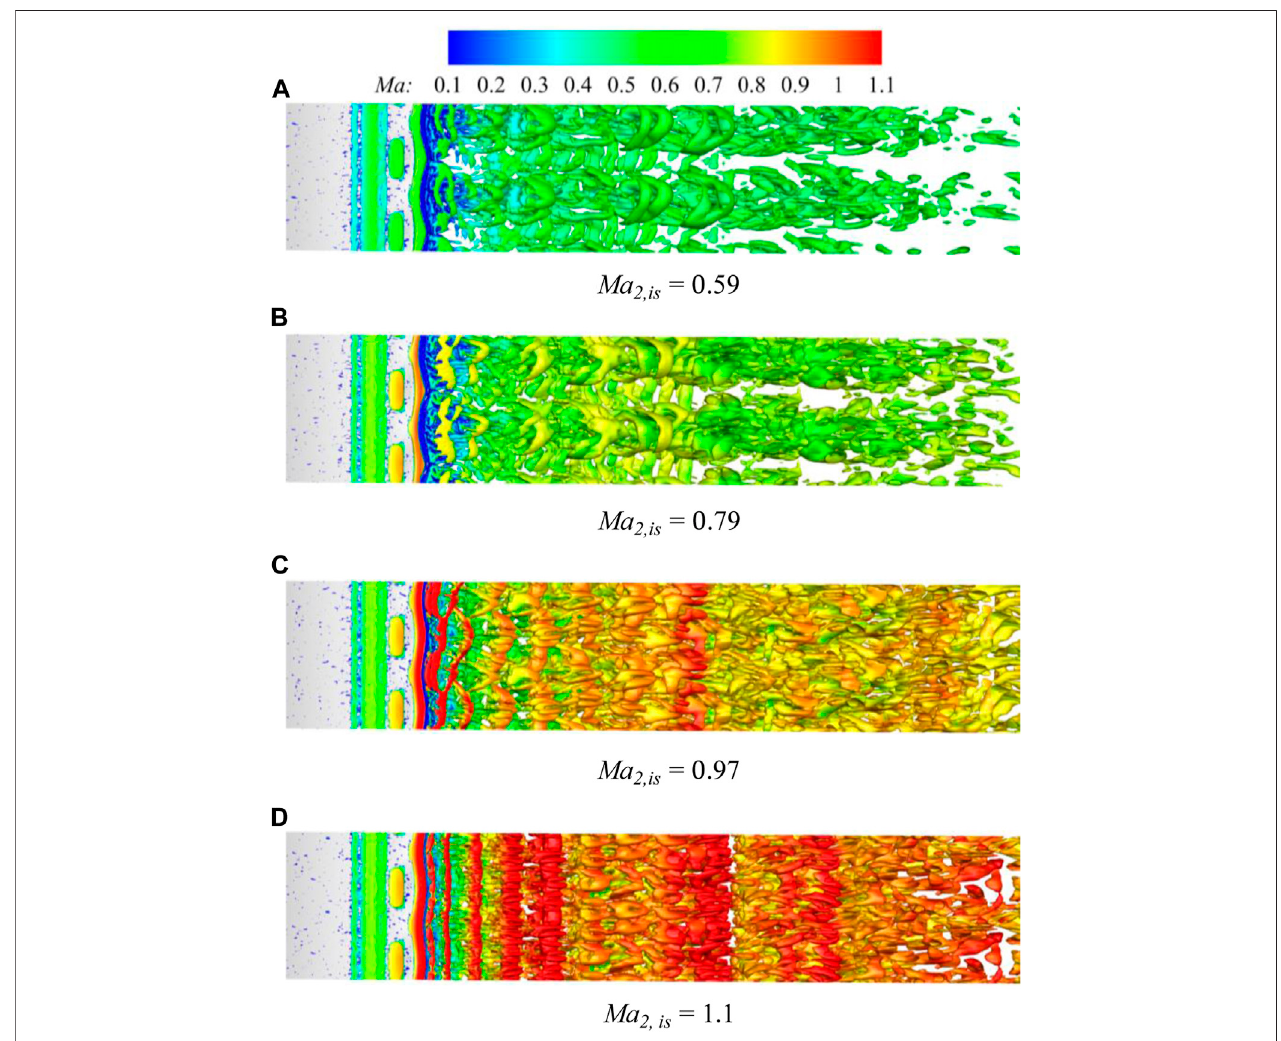
FIGURE 10 | The Q-criterion ( Q (cid:1) 1 × 10 7 ) isosurface of the BTE dyed with Mach number under different Mach numbers. (A) Ma 2 , is (cid:1) 0 . 59. (B) Ma 2 , is (cid:1) 0 . 79. (C) Ma 2 , is (cid:1) 0 . 97. (D) Ma 2 , is (cid:1) 1 .